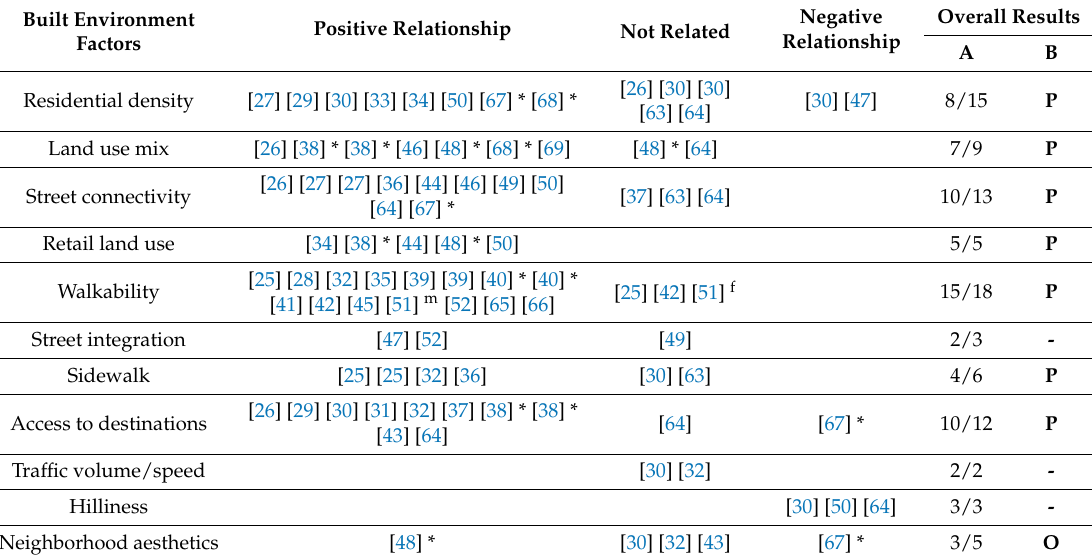
Table 6. Summary of relationships between built environment and walking for transport.